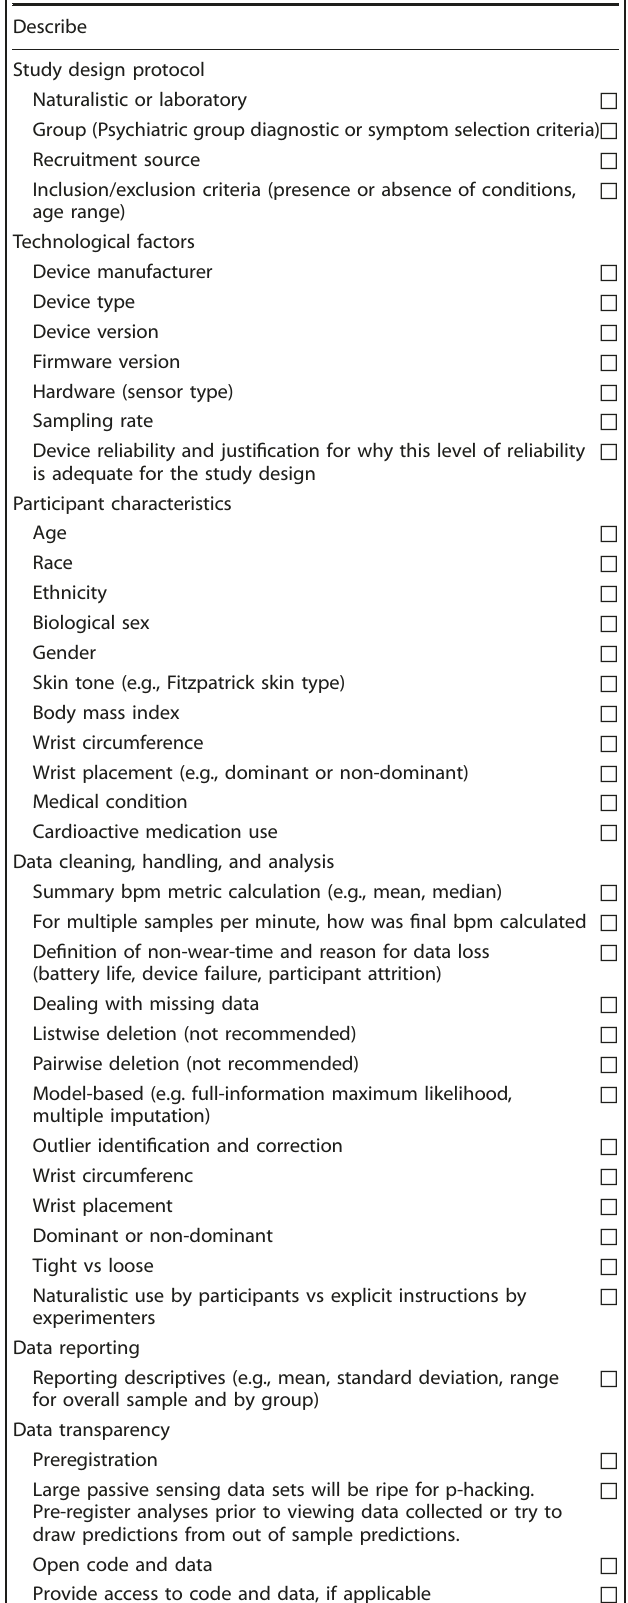
Table 2. mHealth wearable heart rate metadata checklist 1: descriptive reporting of